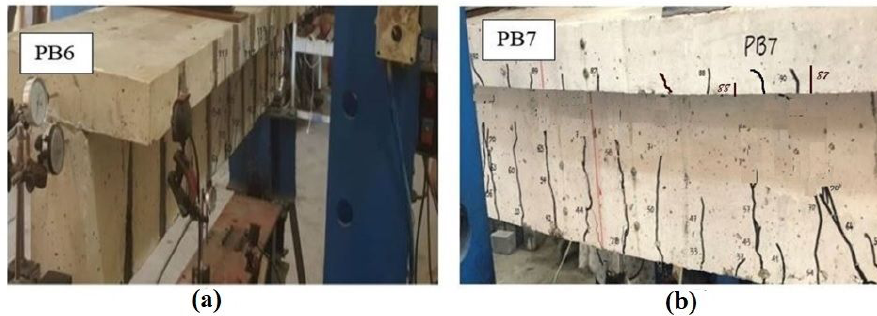
Figure 9: Cracking patterns of chemical connecting beams: (a) PB6; (b)